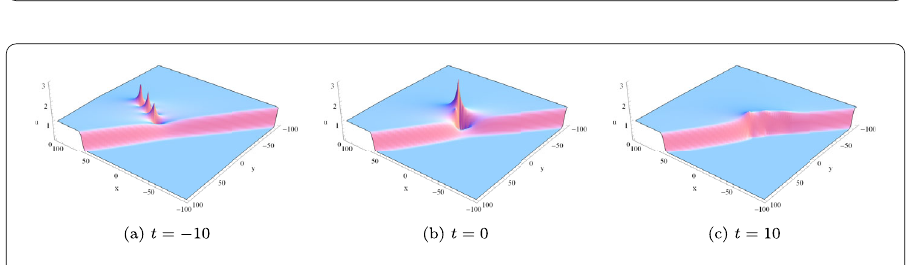
Figure 8 Plot of three lumps and a kink soliton fusion with parameters p 1 = 0.5 + 0.4 i , c 11 = c 12 = c 13 = 1, γ 11 =